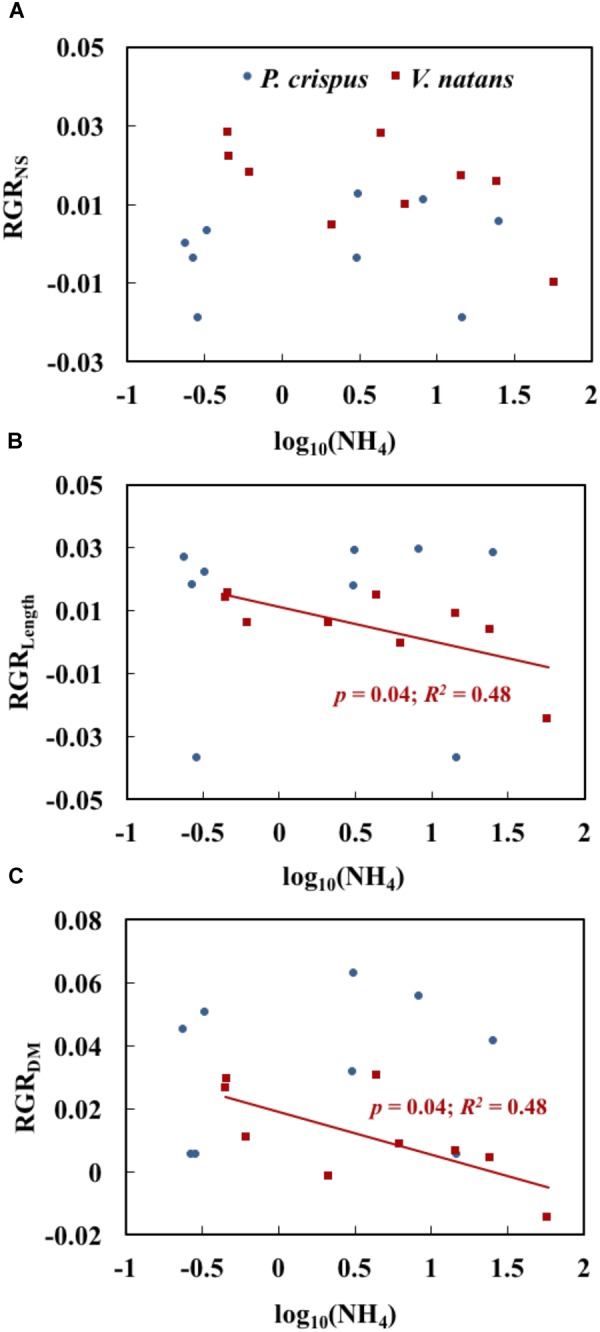
Relationships of NH4 (the measured concentration of total ammonium, including both NH3 and NH4+) with the relative growth rate of shoot number (RGRNS) (A), relative growth rate of length (RGRLength) (B), and relative growth rate of dry mass (RGRDM) (C) of Potamogeton crispus and Vallisneria natans (n = 9 for both species) (The analyses were based on the data in lower layer with a depth of 1.2 m, which is more natural). The red and blue R2 and p correspond to the red and blue line, respectively.